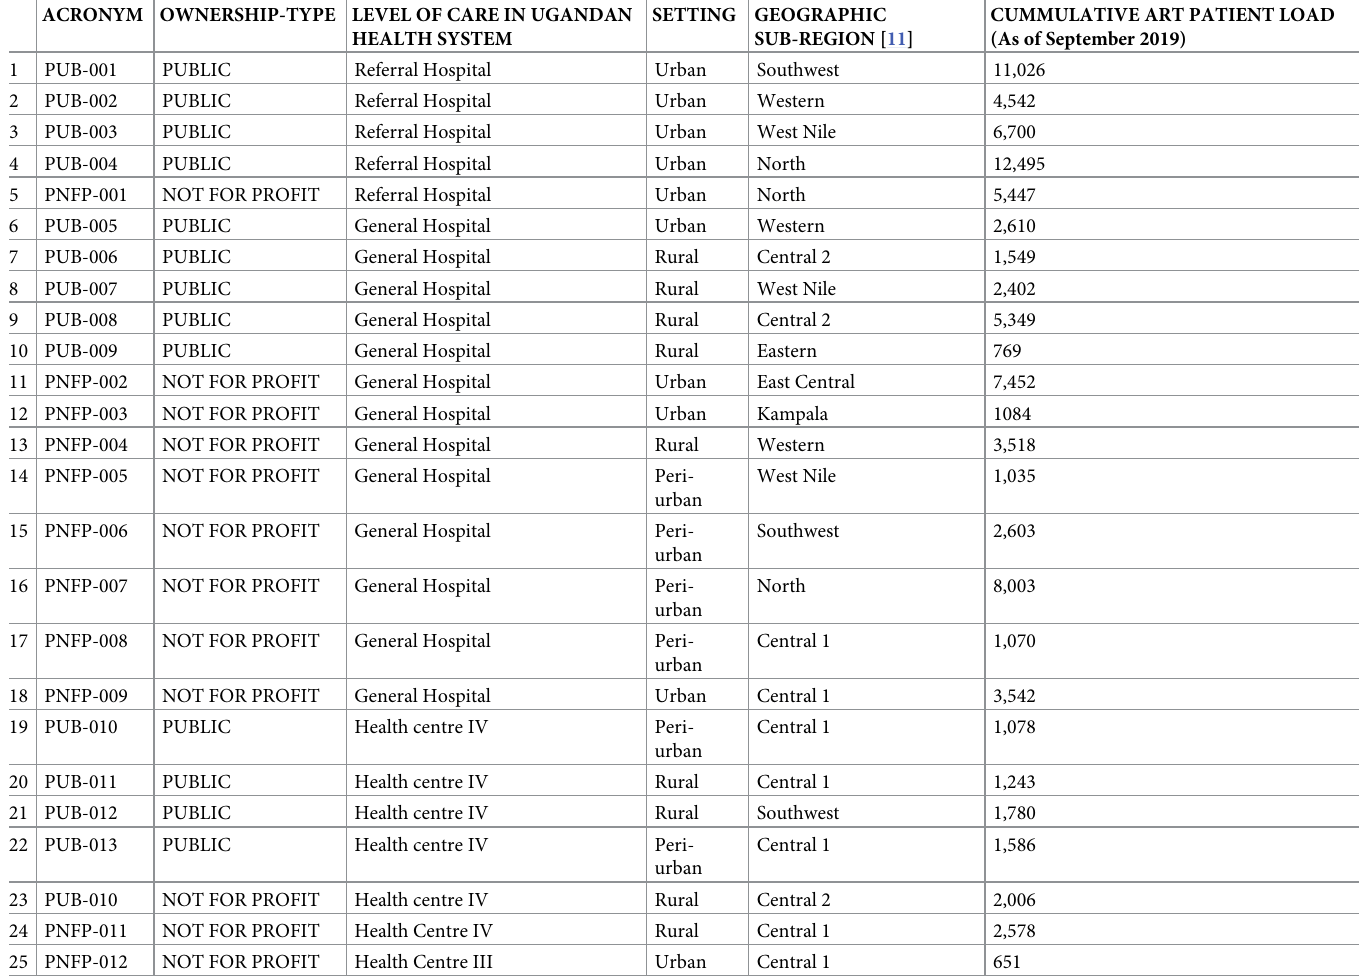
Table 3. Characteristics of health facilities implementing all five DARTS